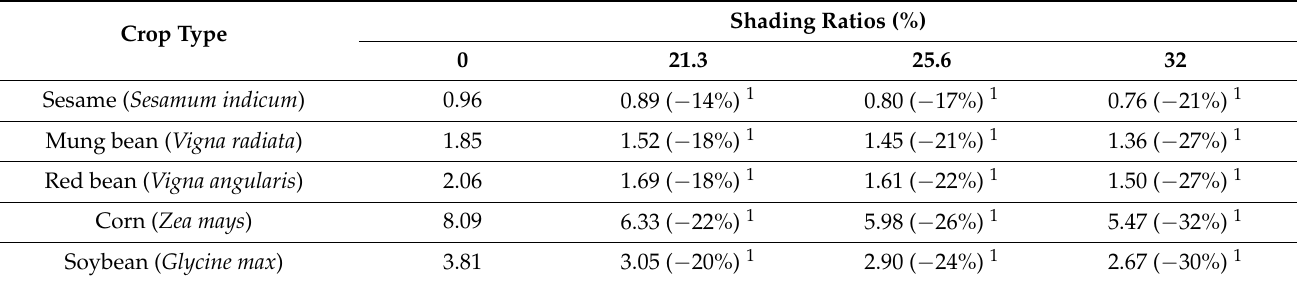
Table 6. The estimated grain yields (Mg/ha) of all five crops.